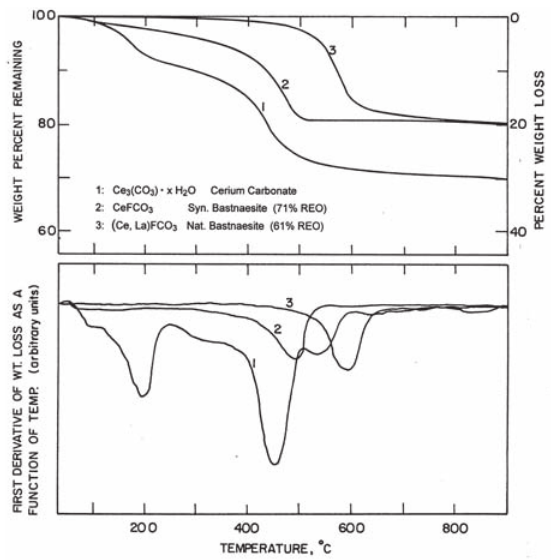
Fig. 2 Thermogravimetric analysis results for cerium carbonate, synthetic bastnaesite and natural bastnaesite (top figure) and the respective dif- ferential curves (bottom